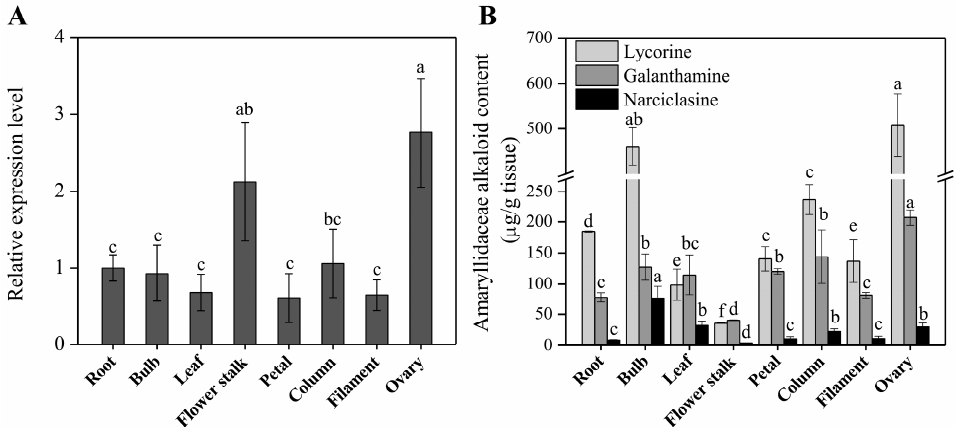
Figure 4. Expression level of the LaOMT1 gene ( A ) and accumulation level of three Amaryllidaceae alkaloids ( B ) in different tissues of L. aurea . The expression level of LaOMT1 was measured using qRT-PCR analysis, and normalized to the reference gene LaEXP1 . The expression of LaOMT1 in root tissue was defined as 1.0. Data represent the mean ± standard deviation (SD) of three independent biological replicates. Different letters indicate significant differences ( p < 0.05) according Duncan’s multiple test.